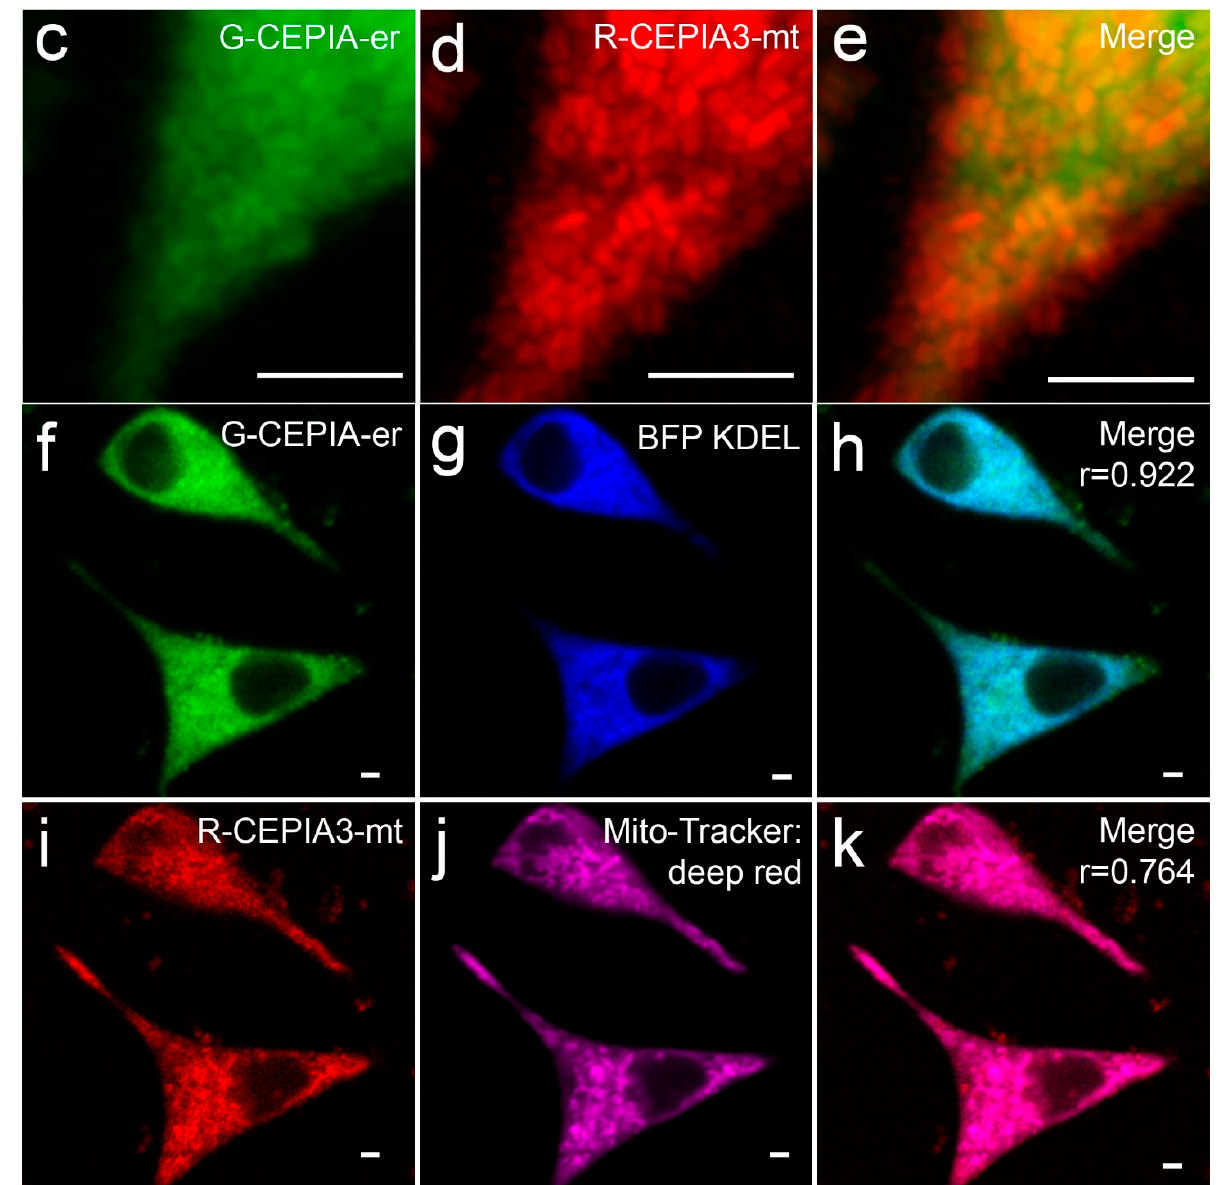
Figure 1. Colocalization of DS-1 to ER and mitochondria. ( a ) Schematic representation of DS-1 showing G-CEPIA-er fused to R-CEPIA3-mt with T2A self-cleaving peptide. The binding affinities of ER and mito Ca 2+ sensors are shown below the schema. The exchange of Ca 2+ within the organelles is shown in the cartoon. The fluorescence associated with Ca 2+ binding to DS-1 in their respective organelles is indicated by their color cues. ( b ) Shows two INS-1 832/13 cells expressing DS-1. Confocal image of INS-1 832/13 cell transfected with DS-1 imaged with green and red laser lines. The enlarged insets shown depict the green ( c ), red ( d ) and a merger of both channels ( e ). The green channel of DS-1 ( f ) and the blue channel of the ER marker BFP-KDEL ( g ) are also indicated. Colocalization of G-CEPIA-er and BFP-KDEL are in ( h ). The Red channel of DS-1 ( i ) and the far-red channel of Mitotracker deep red ( j ). Co-localization of R-CEPIA3-mt paired with Mitotracker deep red is shown in ( k ). The correlation values of the merged colors were obtained from JaCOP plugin in ImageJ and their values are indicated. The scatter plots for the colocalized images shown in Figure 1b,h,k are shown in Figure S1a–c. The scale bar represents 2 µ